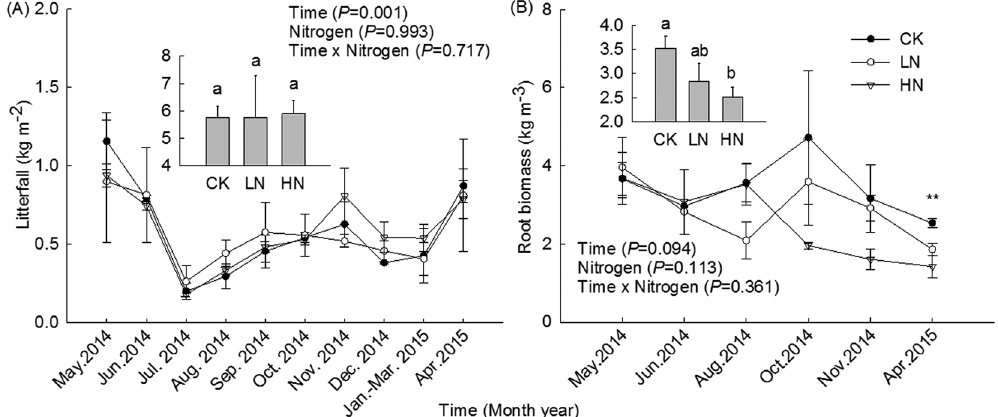
Figure 1. Litterfall mass and root biomass under different nitrogen treatments in a secondary evergreen broad- leaved forest ecosystem in southwestern China, from May 2014 to April 2015. Histograms indicate annual mean values. Plots received three levels of N addition, while control plots received none. Monthly applications of NH 4 NO 3 began in April 2013. Values are means ± SE. Bars indicate ± 1 SE, N = 3. The results of repeated measures ANOVAs are shown for each parameter. Double asterisks ( ** ) indicate a significant difference between the control and at least one experimental N treatment at P < 0.01. Different letters denote